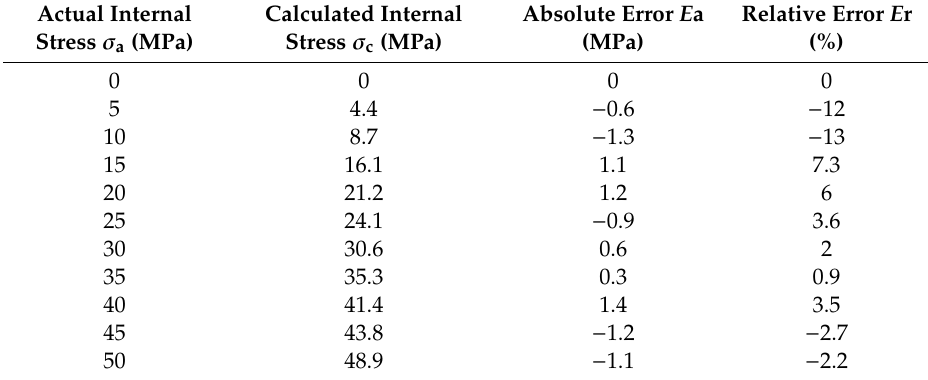
Table 1. The actual internal stress σ a , calculated internal stress σ c , absolute error E a , and relative error E r of specimen